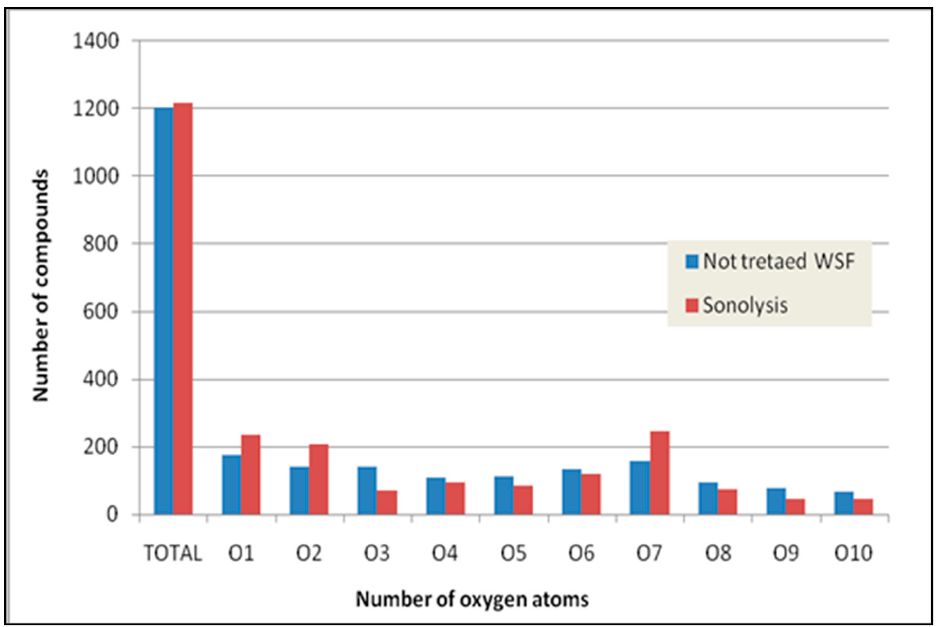
Figure 9. FT-ICR analysis of natural and 1-h sonicated WSF of crude oil samples asa function of the number of oxygen atoms.